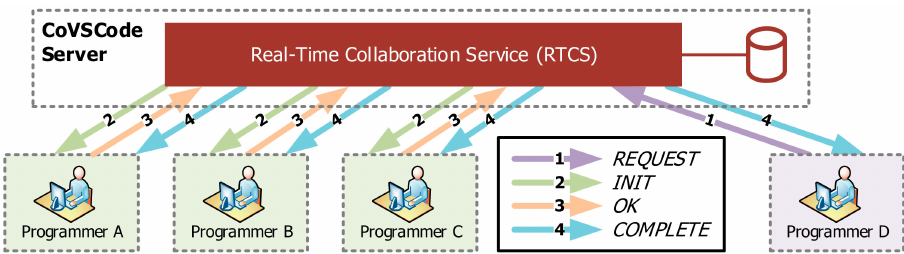
Figure 5. A graphical example illustrating the transition when a member joins the